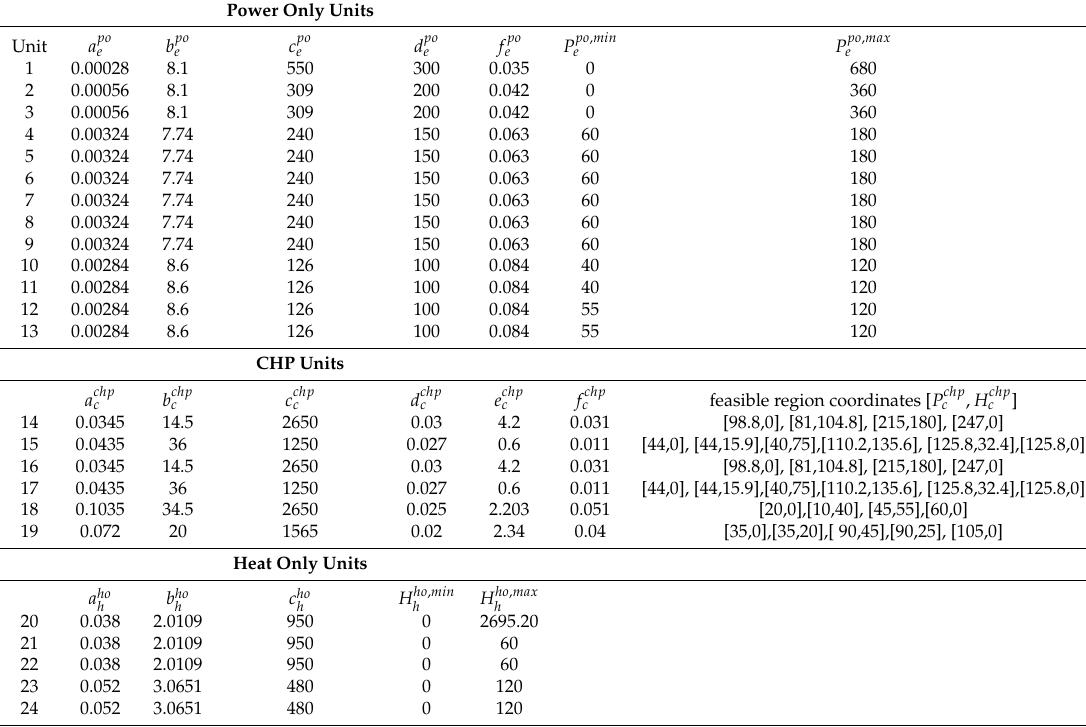
Table 10. Cost function parameters of test system II.